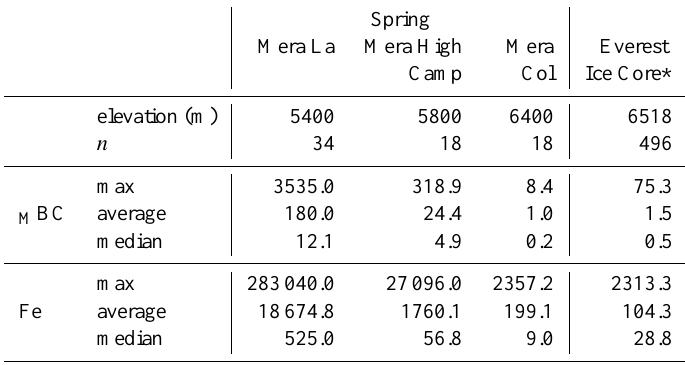
Table 1. M BC and Fe in snow and ice samples from Mera glacier and a Mt. Everest ice core. Spring Mera La Mera High Mera Everest Camp Col Ice Core* elevation (m) 5400 5800 6400 n M BC